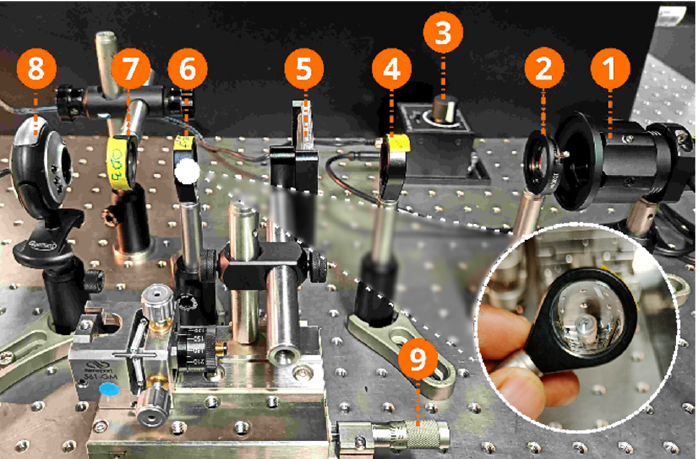
Figure 6. Photograph of the experimental setup: (1) LED source, (2) Iris, (3) LED power source, (4) Lens L1 ( f = 50 mm), (5) Test object, (6) Lens L2 ( f = 35 mm), (7) ND filter (ND 1.5), (8) Image sensor and (9) XY stage movement controller.